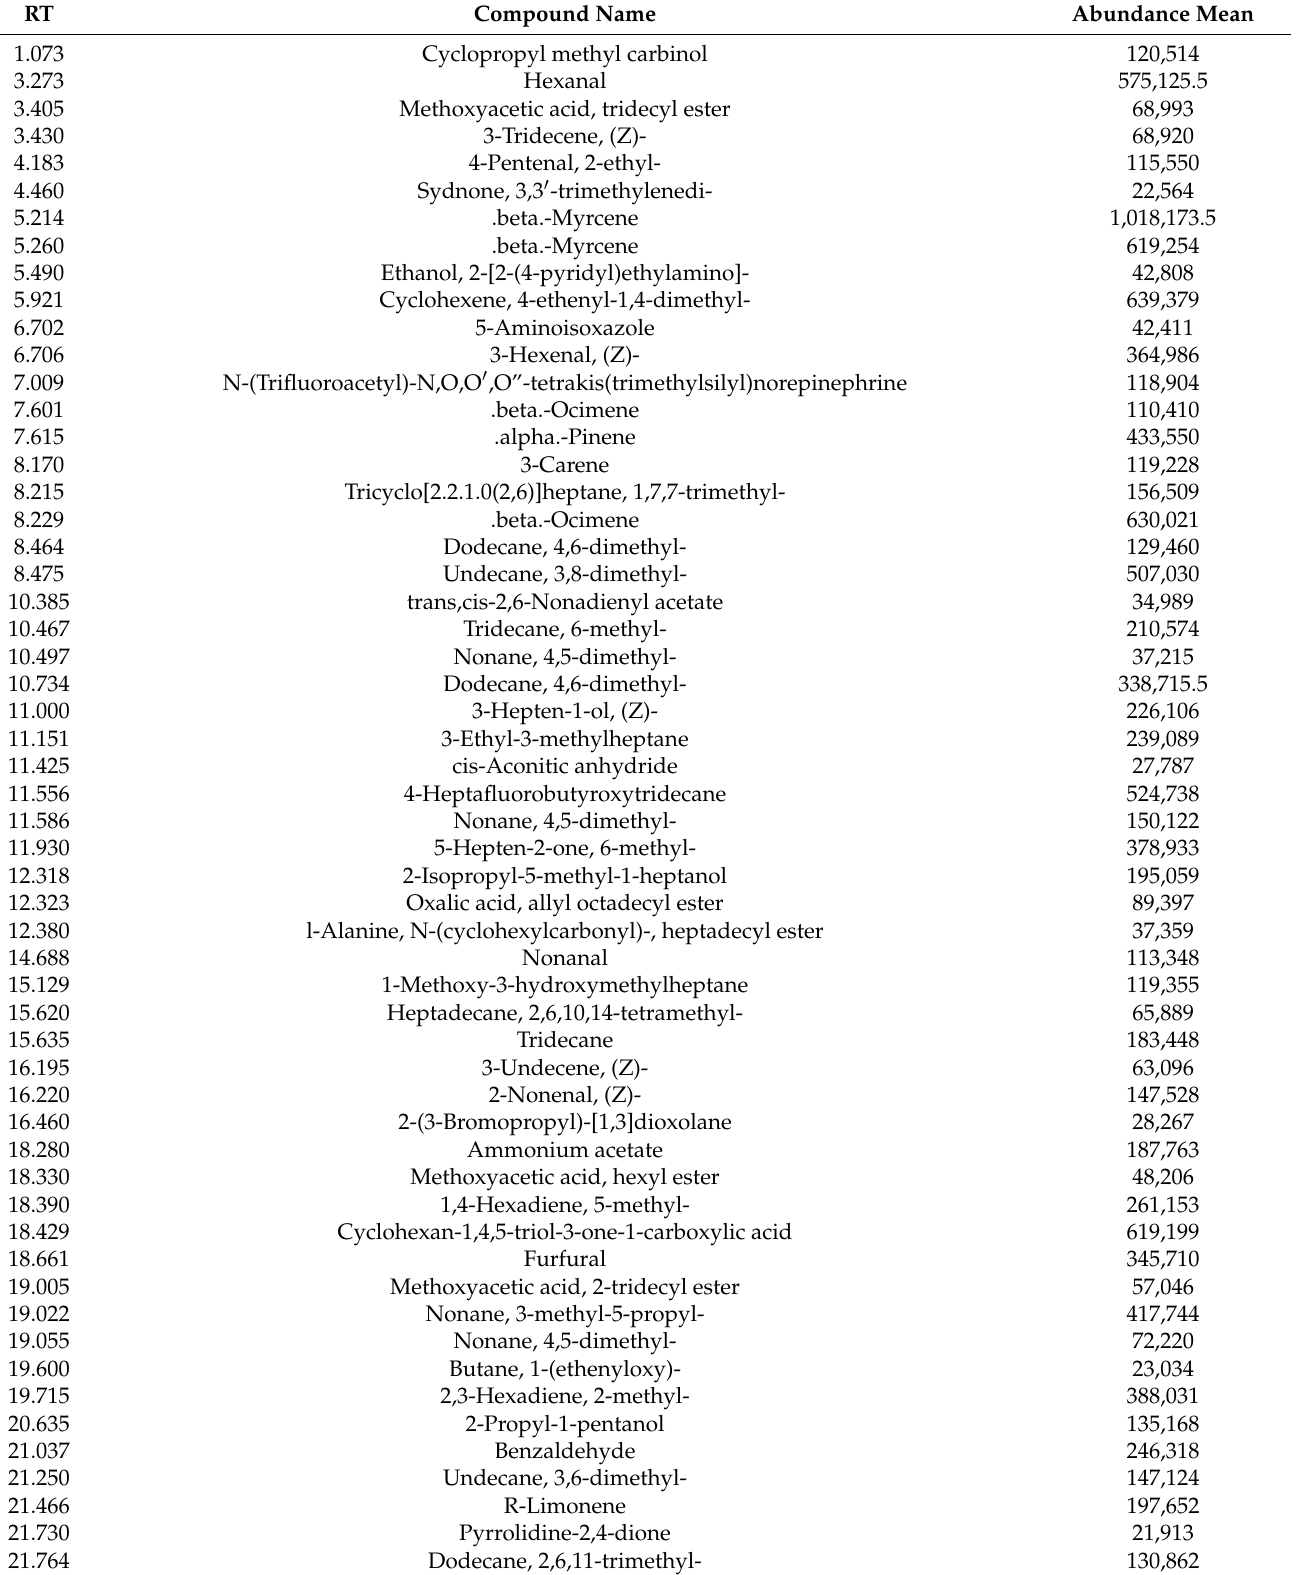
Table A2. Results for the SGP sample fingerprint determination with indication of the retention time (RT) and abundance mean for every identified